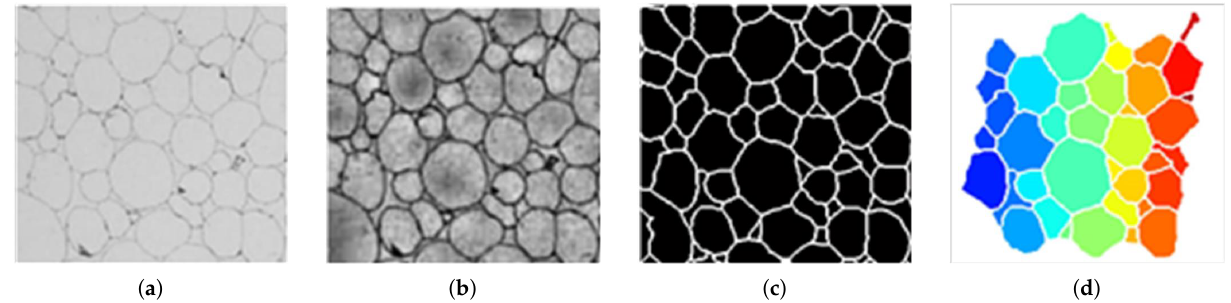
Figure 9. Results of micrograph processing: ( a ) initial, ( b ) enhanced, ( c ) skeletonized, and ( d )